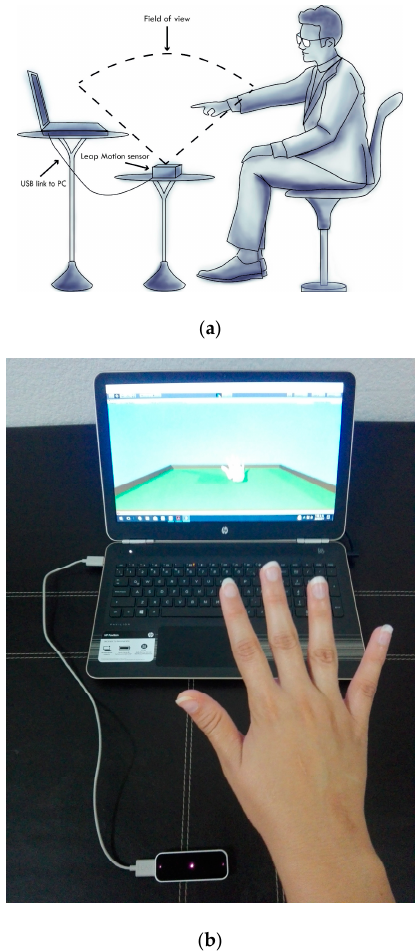
Figure 3. Experimental tests. ( a ) Scheme showing the position of the patients and the elements to acquire the signal. ( b ) View of the patients when they perform the task using a natural interaction system through a virtual reality interface. Table 1. Distribution of patients in different tremor level, gender, and the hand used. Tremor level